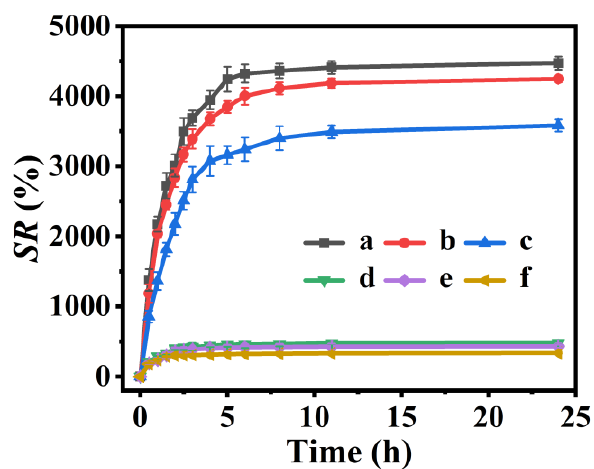
Figure 5. SR profiles of P(NA- AA)−0−y at 37.0 ℃ under pH 7.4 (y = 0.1 (a), 1.0 (b), and 10.0 (c)) and 2.0 (y = 0.1 (d), 1.0 (e), and 10.0 (f)). 2.0 (y = 0.1 (d), 1.0 (e), and 10.0